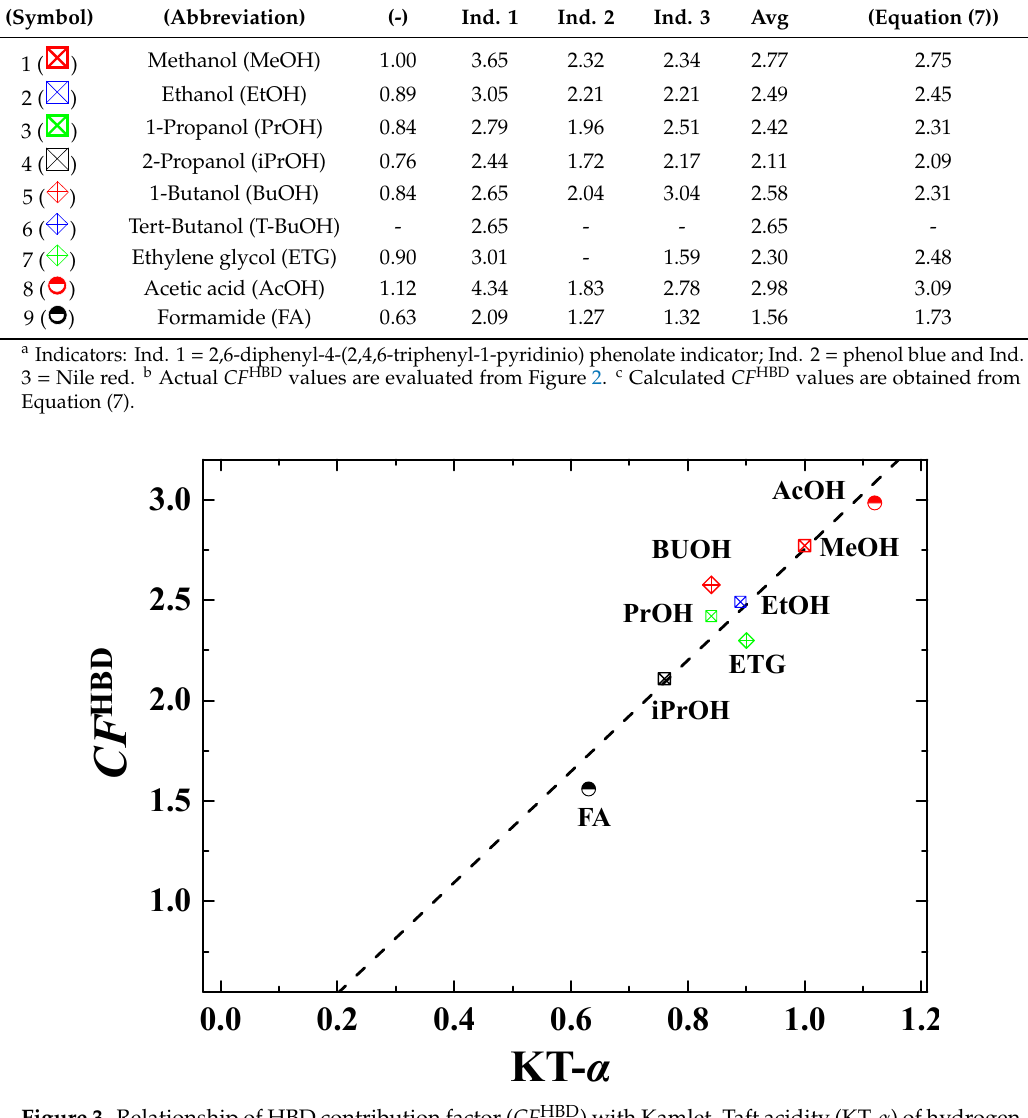
acetonitrile (ACN), tetrahydrofuran (THF) and gamma-butyrolactone (GBL) that showed a sigmoid function (Figure 5a–c). Blue solid lines (Figure 5) show predicted E T values of the aqueous mixture using Equation (2) without CF HBD value ( CF HBD = 1) that generally tended toward the experimental data (symbols, Figure 5). Table 2 shows a comparison of ARD values obtained between the ideal model (Equation (1)) and predictive model (Equation (2)) for the aqueous mixtures of HBA cosolvents (entries 1–9, Table 2) Figure 3. Relationship of HBD contribution factor ( CF HBD ) with Kamlet–Taft acidity (KT- α ) of hydrogen bond donor (HBD) cosolvents at 25 °C. The CF HBD and KT- α data are given in Table 1. Dashed line represents Equation (7). Symbols of HBD solvents are given in Table 1.